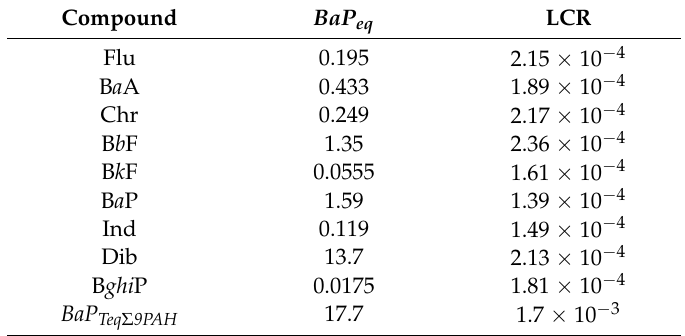
Table 6. Benzo[ a ]pyrene toxic equivalent concentration and lung cancer risk (total